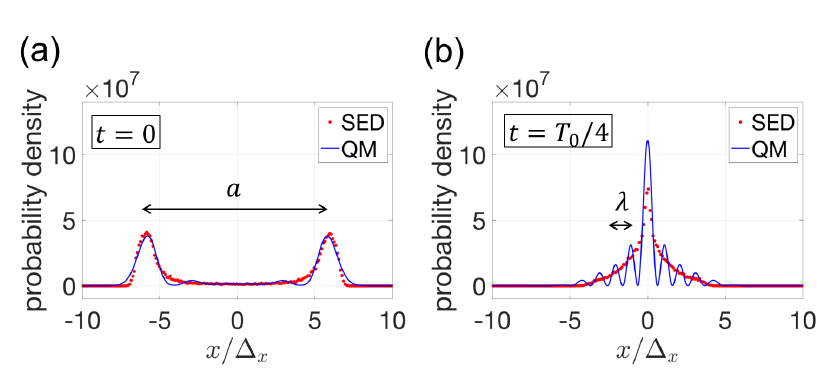
Figure 4. Comparison between the QM and SED probability distributions at t = 0 and t = T 0 /4 in Figure 2. ( a ) The agreement between QM and SED probability distributions is good when the two macroscopically distinct QM wavepackets are well-separated by a peak-to-peak distance a beyond the ground state width ∆ x , a (cid:29) ∆ x . ( b ) After a quarter of the natural period T 0 /4, the two QM wavepackets recombine in the harmonic potential. Interference fringes appear in the QM distribution ( blue line ) but not in the SED distribution ( red dots ). The fringe periodicity λ is determined by the wavepacket separation a in ( a ) through the relation λ = 2 π ¯ h / m ω 0 a , which resembles the well-known double-slit diffraction formula. The SED probability distribution captures the outline of the QM distribution as if the quantum coherence between the two QM wavepackets is